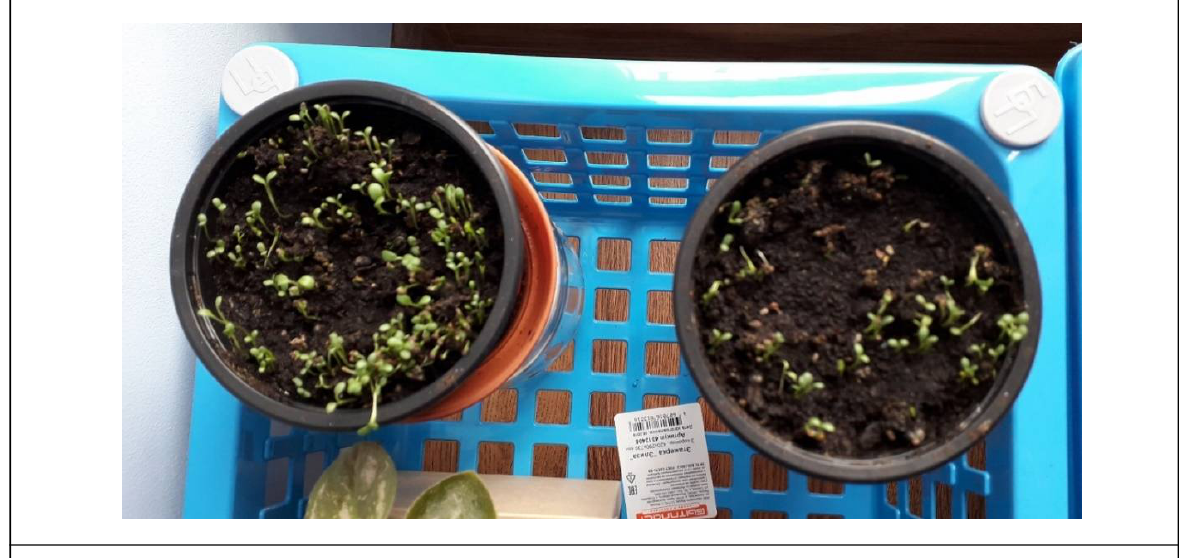
Figure 3: On the left is ordinary water, on the right is magnetized water (April 21, 2019) The trifolium repens irrigated with ordinary water grew much faster than the trifolium repens irrigated with magnetized water, but it was also less viable. So, two weeks after germination, most of the sprouts irrigated with ordinary water died. At the same time, the sprouts irrigated with magnetized water continued to grow and develop in the same amount (Figure